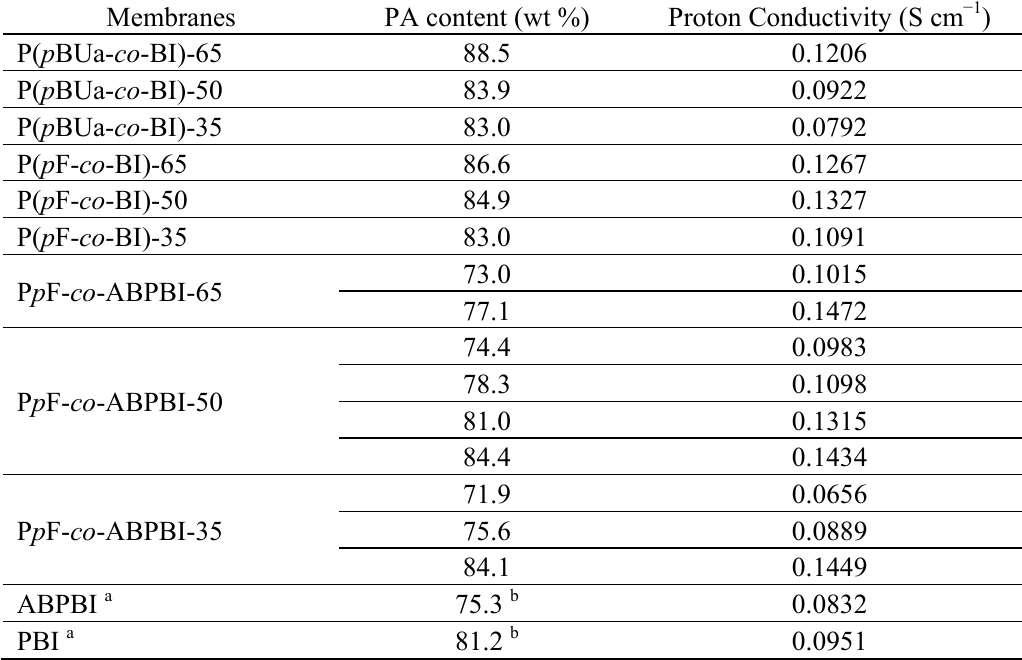
Table 1. Proton conductivity of phosphoric acid (PA)-doped polybenzoxazine (PBOA)- co -PBI (or ABPBI) membranes at 150 °C under un-humidified conditions. Membranes PA content (wt %) Proton Conductivity (S cm − 1 ) P( p BUa- co